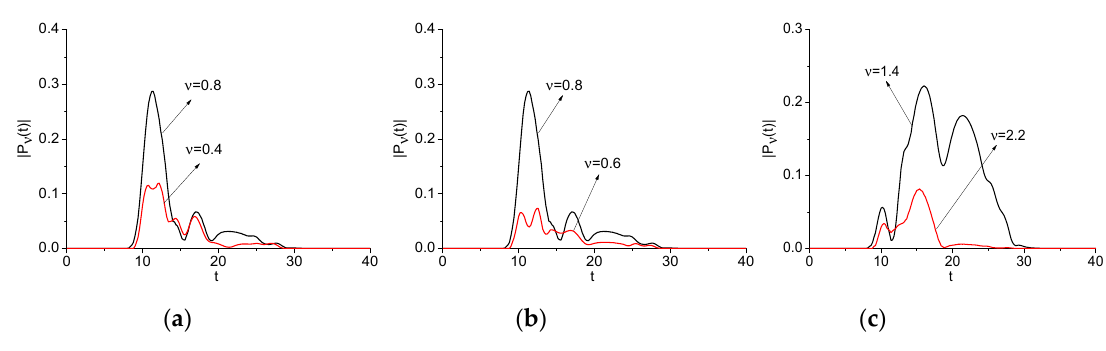
ν = 0.8 ( a ), ( b ), 1.4 ( c ) =0.8 (a), (b) , 1.4 Figure 7. Evolution of the spectral amplitude modulus at the basic frequencies ν base base